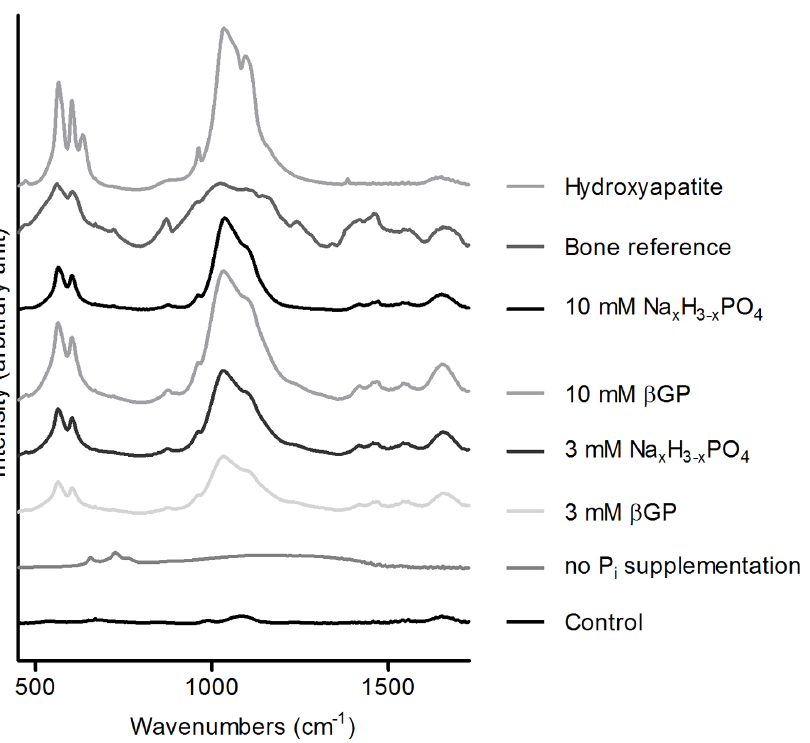
Figure 4. FT-IR spectra. FT-IR spectra (450–1750 cm 2 1 ) of samples cultured in different osteogenic induction or control media (n=1) show the characteristic hydroxyapatite bands and the bands characteristic of the organic matrix of bone.